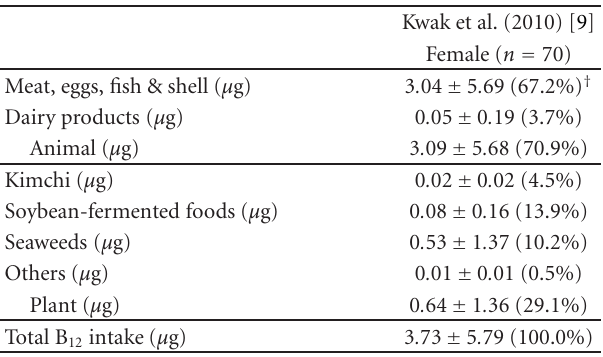
Table 7: Distribution of daily vitamin B 12 intake from total and animal